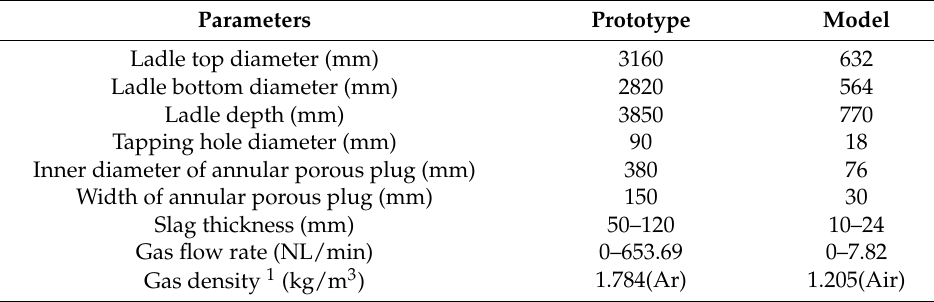
Table 1. Main parameters for model and prototype.